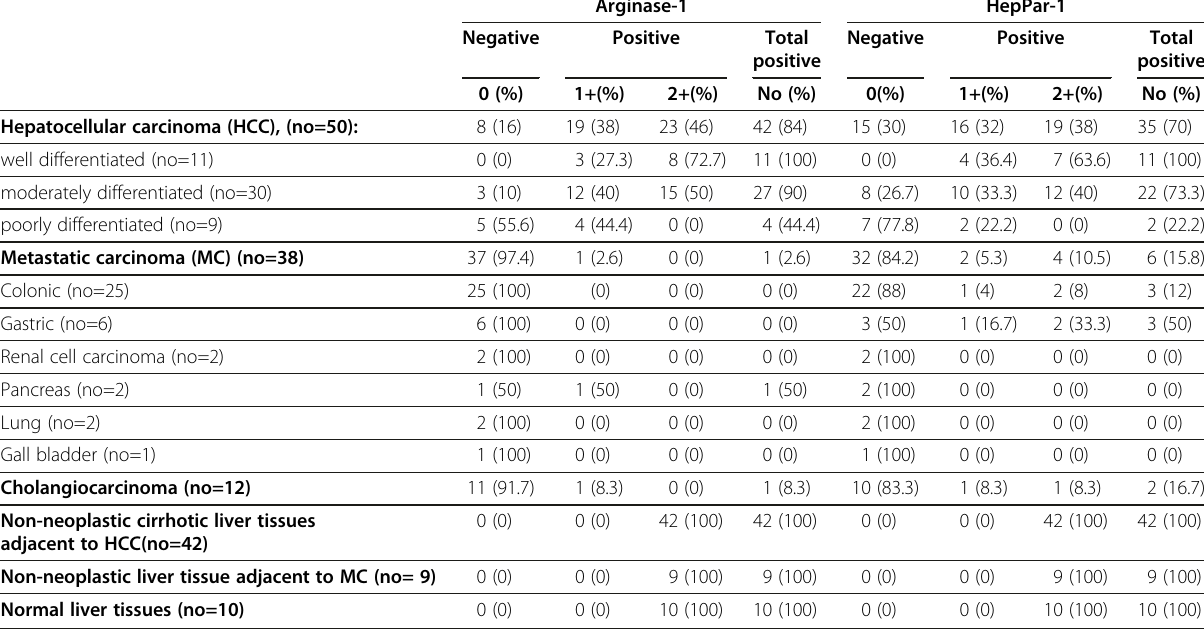
Table 2 Summary of immunohistochemical expression of arginase-1and HepPar-1 in all the studied